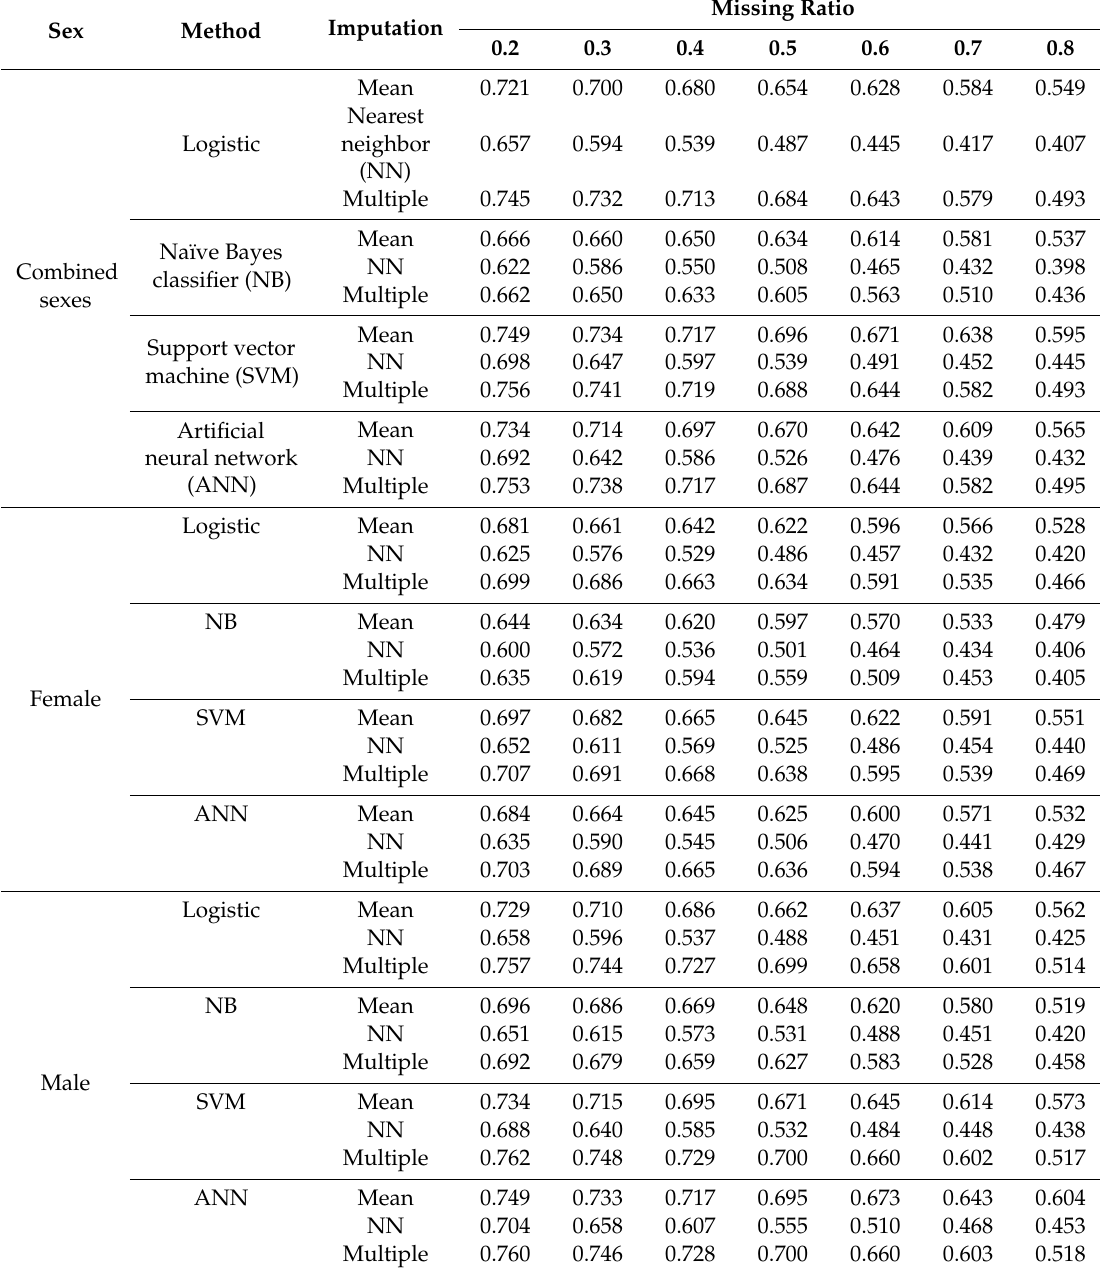
Table 2. Accuracy results by imputation method and learning algorithm: Upper